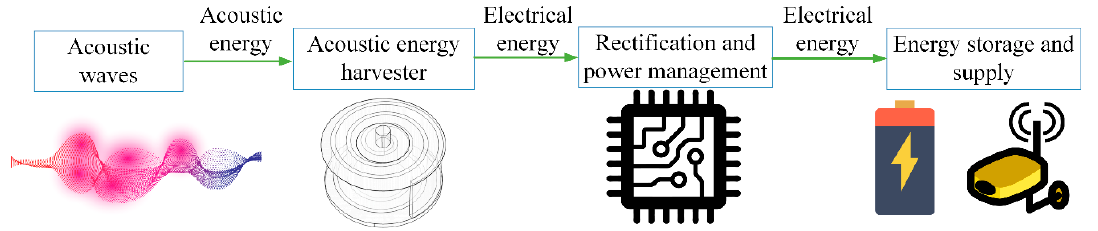
Figure 1. Schematic diagram of an acoustic energy-harvesting (AEH) system.